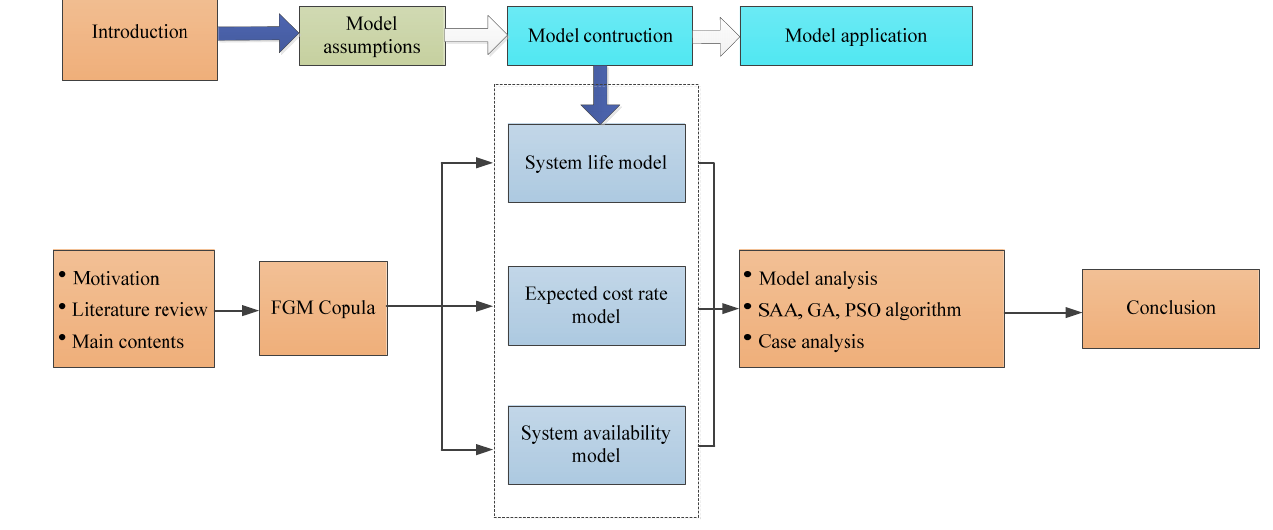
Figure 1. Thesis